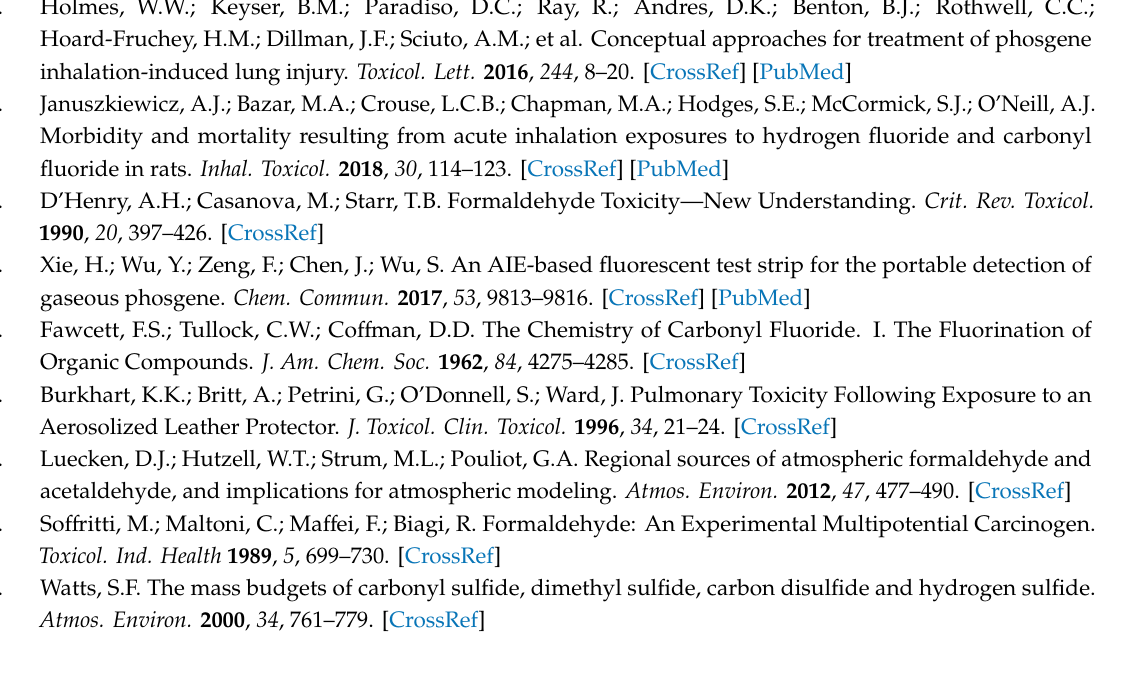
Table S1: Cartesian coordinates, lowest vibrational frequencies, and total energies of 9Py and the 9Py-HC complexes. Funding: This research received no external